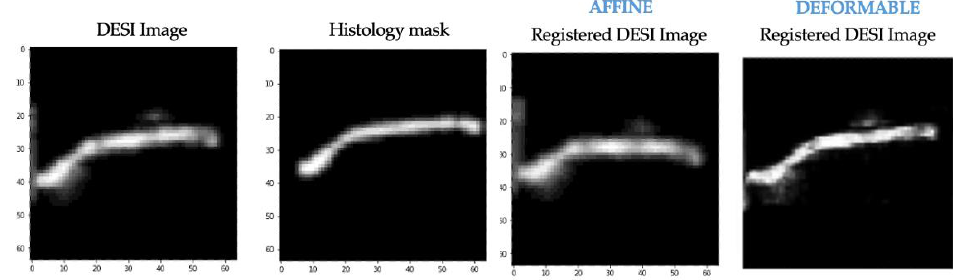
Figure 12. After training experiment 1. Left to right — DESI image (moving), histology masks (fixed), transformed DESI image (moved) — affine transformation, transformed DESI image (moved — deformable transformation.